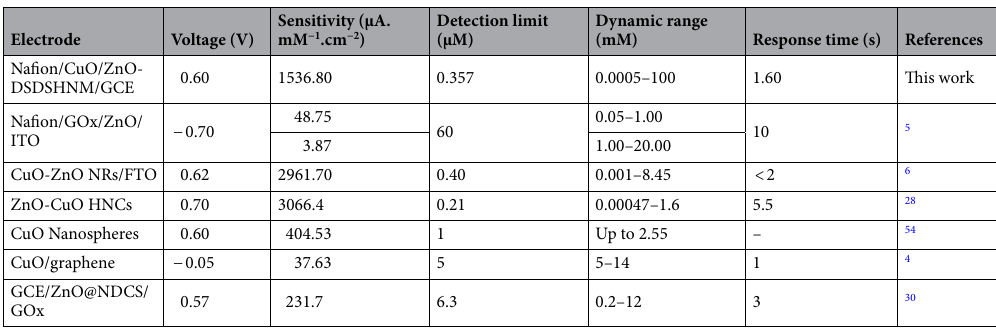
Table 1. Performance comparison of the proposed sensor to the previous works.